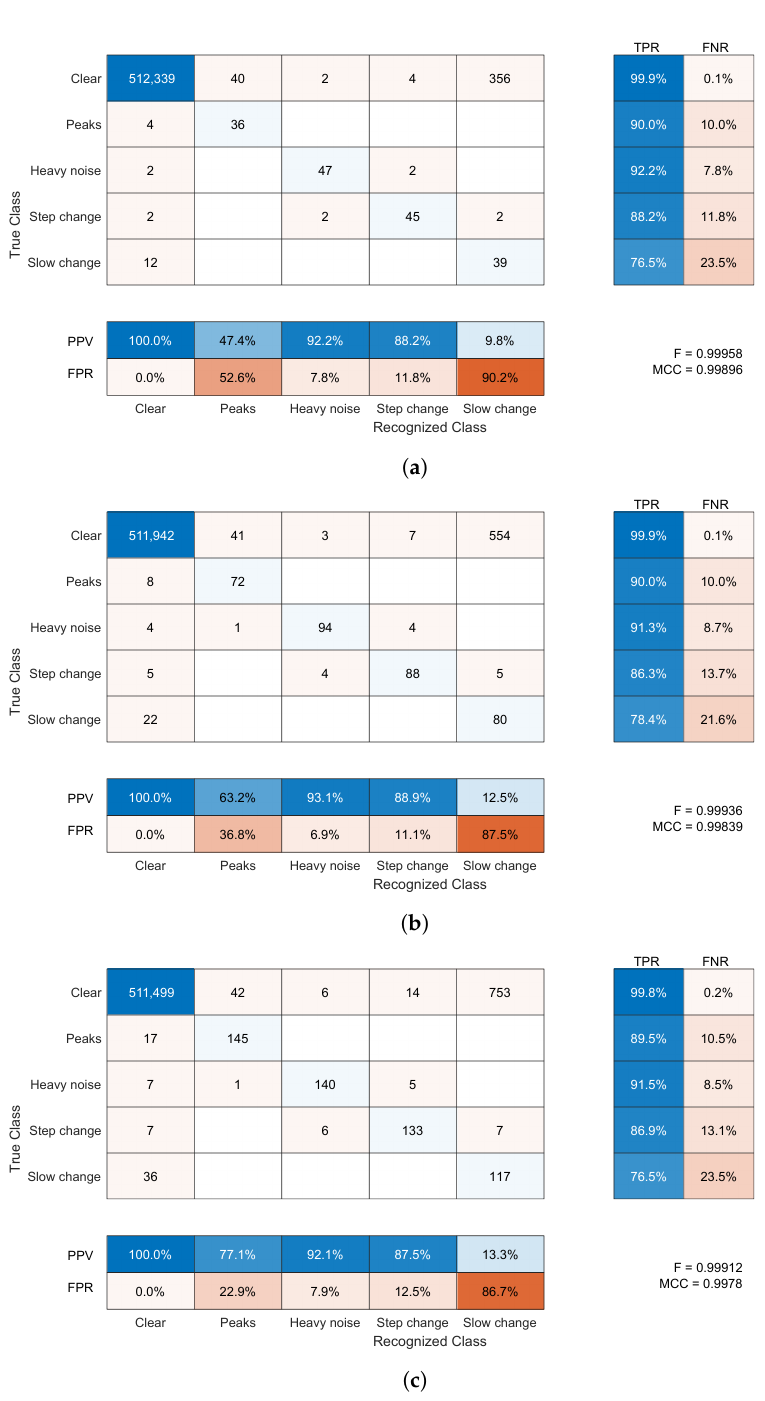
Figure 14. Average confusion matrix for detection of synthetic noises for a 1000-fold simulation with 10-mm average amplitudes of distortions and shares: ( a ) 5%, ( b ) 10%, ( c ) 20% of time (blue—successful results,